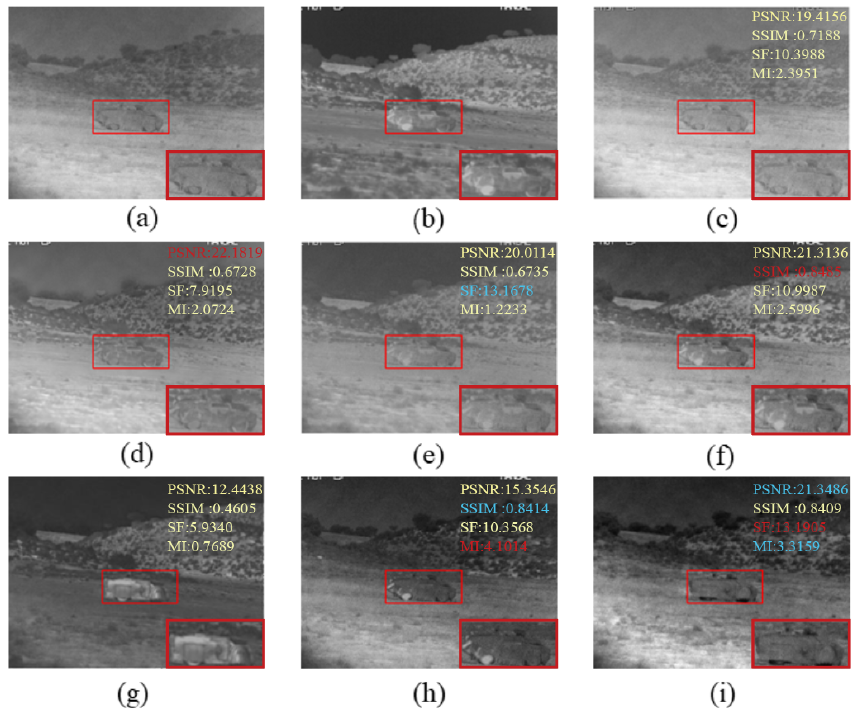
Figure 4. Qualitative comparison of LCF with six state-of-the-art methods on armored. For a clear comparison, we select a salient region (i.e., the red box) in each image and enlarge it in the bottom right corner. In addition, the evaluation indicators are displayed on the top right, with red representing the best and blue the second best. ( a ) Visible image; ( b ) Infrared image; ( c ) LP; ( d ) GTF; ( e ) MSVD; ( f ) Nestfuse; ( g ) VIF; ( h ) STD; ( i )